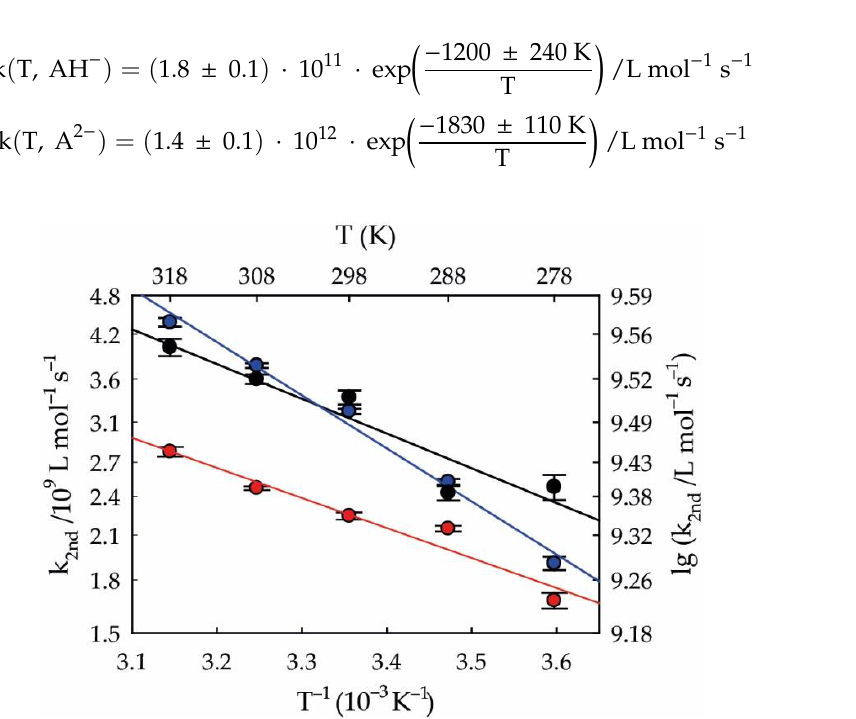
Figure 3. Arrhenius plot of pH dependent OH radical reactions with pimelic acid in their different protonation forms AH 2 (red), AH − (black), and A 2− (blue).